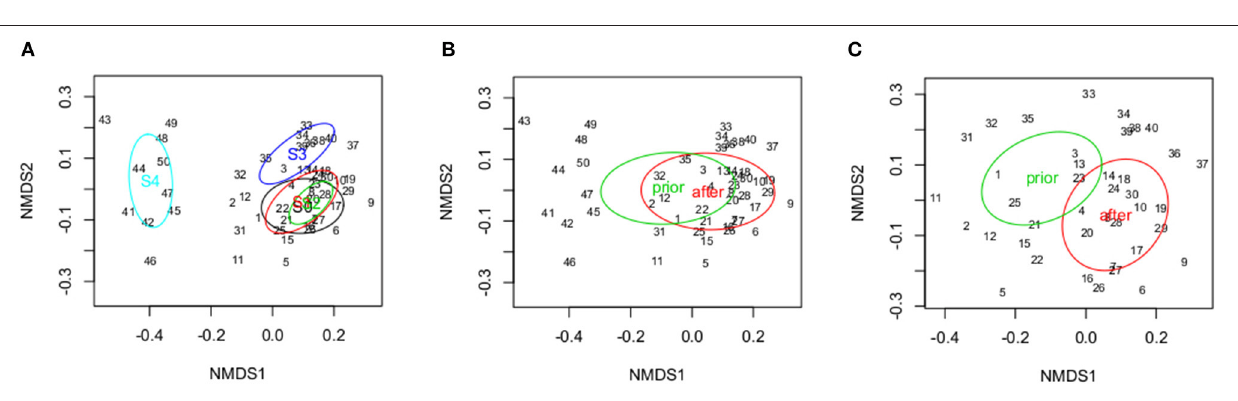
FIGURE 7 | NMDS (non-metric multidimensional scaling) for the dataset of the whole macrozoobenthic community. (A) Difference between the river Schussen (S 0, S 1, S 2, and S 3) and the river Argen (S 4). (B) NMDS including S 4 (Argen). Significant difference between the datasets prior to and after the upgrade of the WWTP. ANOSIM: p = 0.014; R statistic = 0.11. (C) NMDS for the river Schussen solely (excluding S 4). Significant difference between the datasets prior to and after the upgrade of the WWTP. ANOSIM: p = 0.001; R statistic =